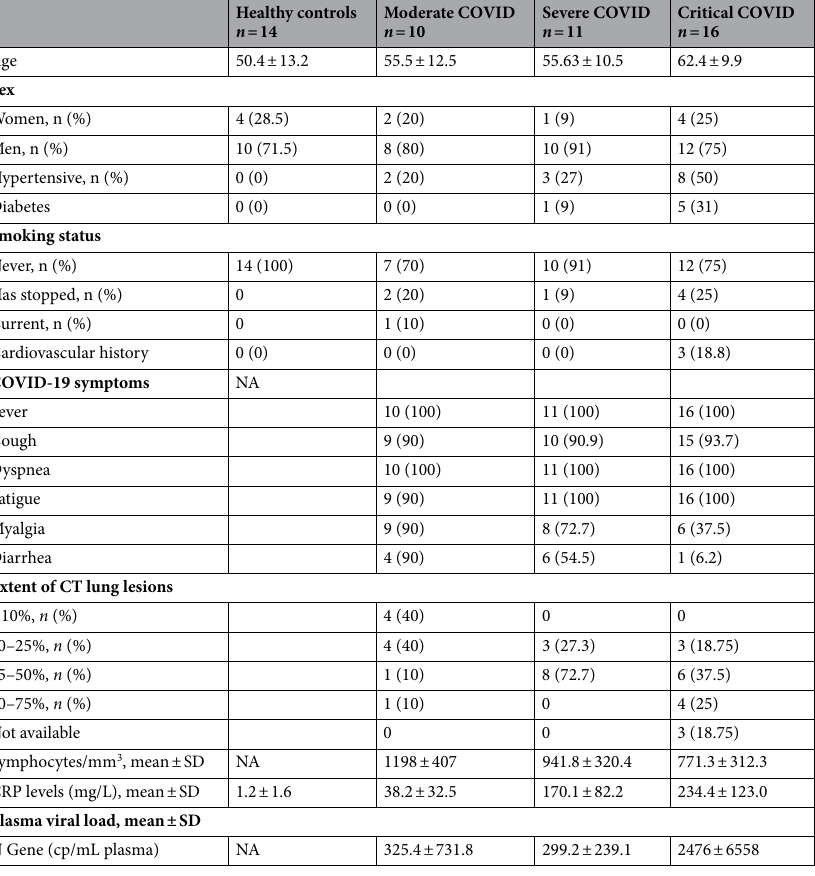
Table 1. Characteristics of the whole population. NA not applicable or not available, SD standard